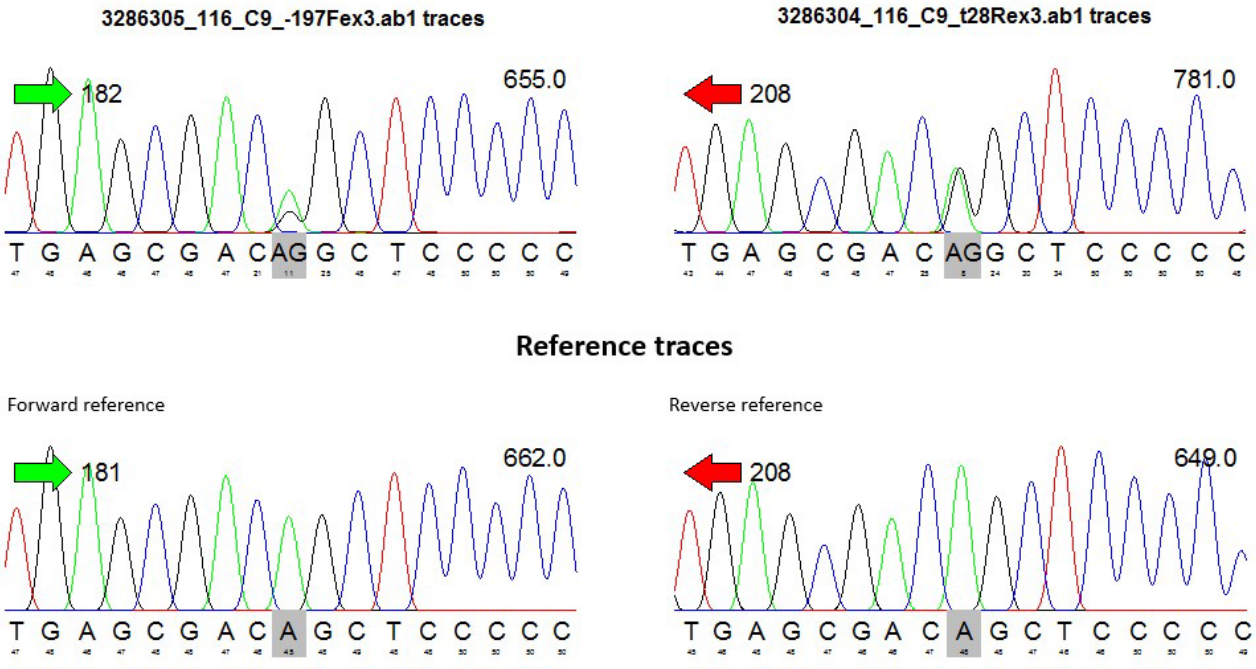
Figure 1. A representative chromatogram analysis of DNA sequencing assessment of data for sample 116 that reveals a heterozygous mutation corresponding to SNP